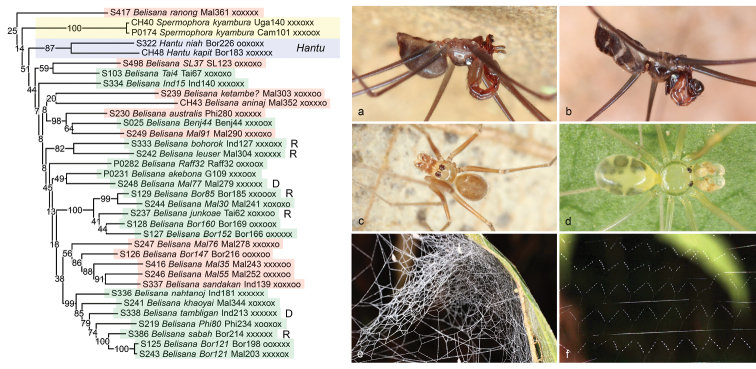
Belisana and Hantu. For Belisana, the background colours signify microhabitat: red = ground; green = leaf. D, domed web; R, highly regular ‘curtain’ web. Photos aHantuniah (Sarawak) bHantukapit (Sarawak) cBelisanasandakan (Sumatra) dBelisanasabah (Sabah) e domed web of Belisana sp. n. “Mal77” (Malaysia) f regular ‘curtain’ web of Belisanabohorok (Sarawak).